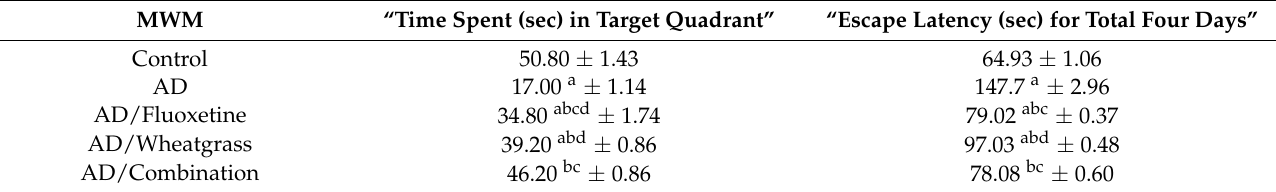
Table 1. Effect of fluoxetine, wheatgrass, or their combination on learning and memory performance in rats. MWM “Time Spent (sec) in Target Quadrant” Control